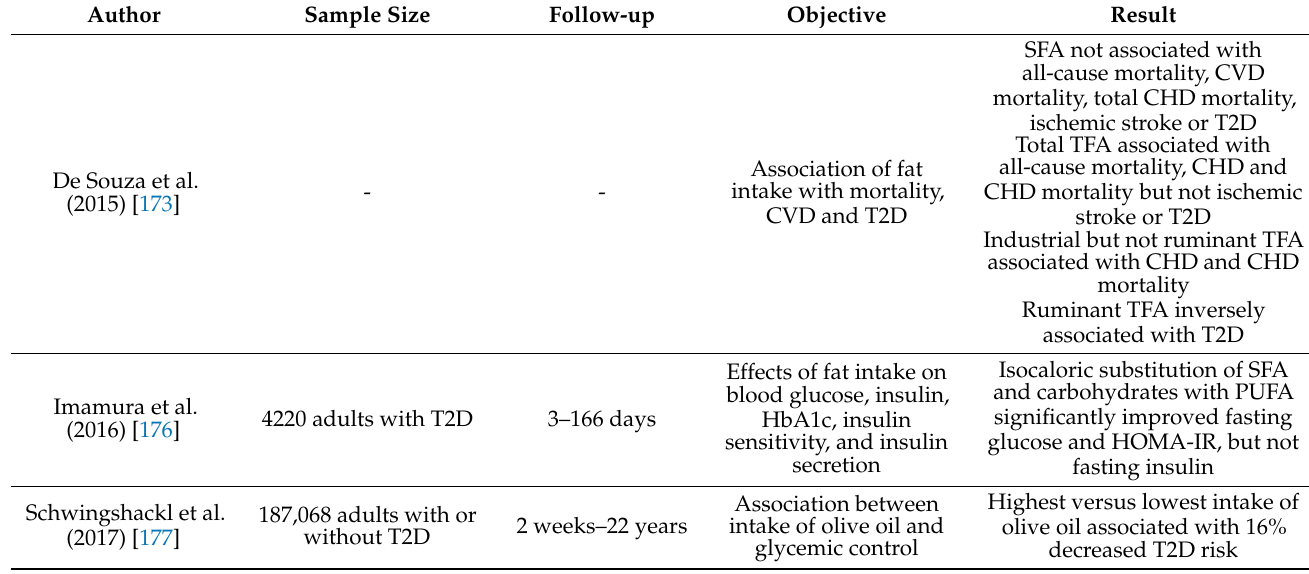
Table 2. Selected systematic reviews and meta-analyses on association of dietary fat with diabetes